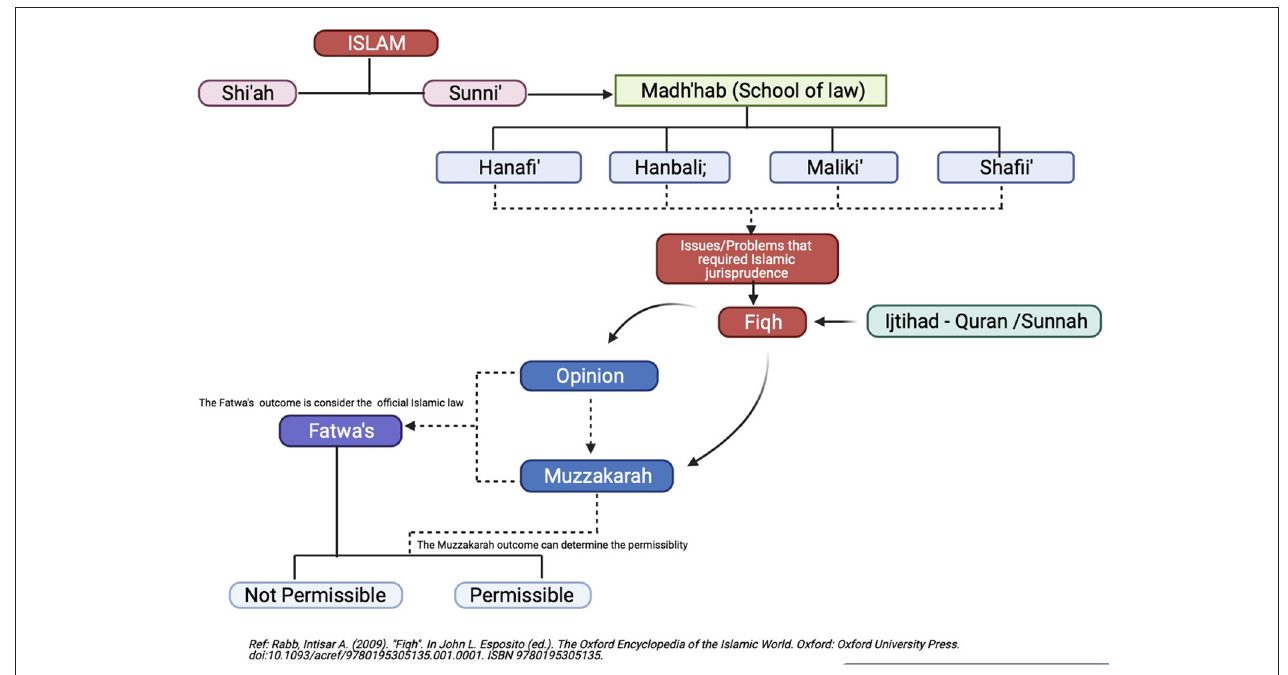
FIGURE 1 | The flow of Islamic